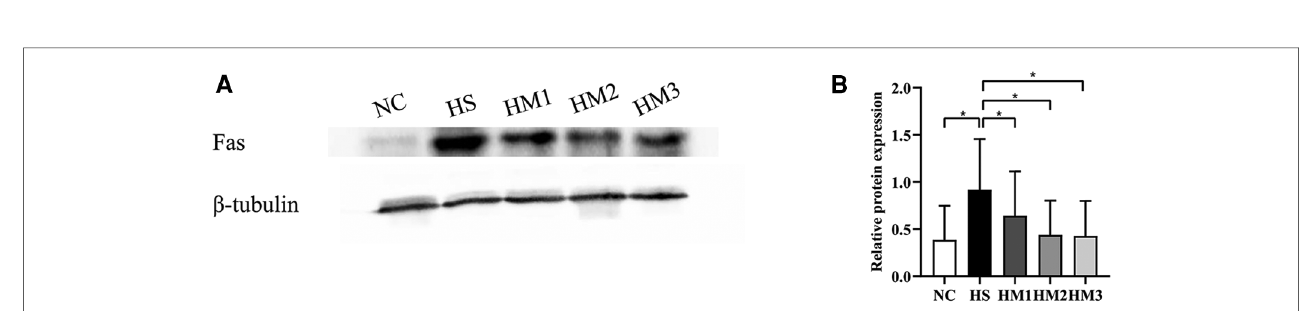
FIGURE 8 Human umbilical cord-derived mesenchymal stem cells (hUC-MSCs) inhibits Fas protein expression in rat pups. ( A ) The protein expression of Fas in the lung tissue evaluated by western blot. ( B ) Statistical analysis of protein expression of Fas. The rat pups of the HS group showed signi fi cantly higher protein expression of Fas than did those of the NC group. hUC-MSCs (1×10 6 cells, 5×10 6 cells, or 1×10 7 cells) downregulated the hyperoxia-induced Fas protein level increase. * P <0.05. Data was presented as means±SEM, n =5 or 6 per